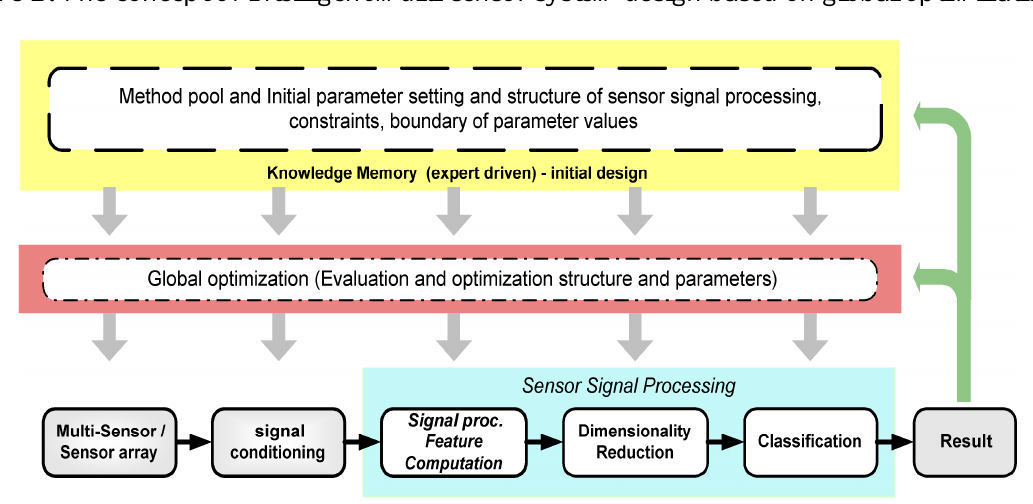
Figure 2. The concept of intelligent multi-sensor system design based on global